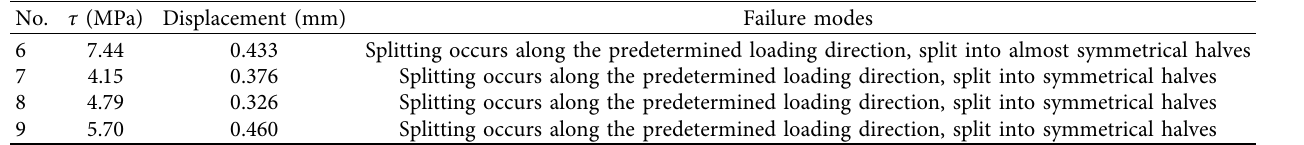
Table 4: Results and failure modes of splitting